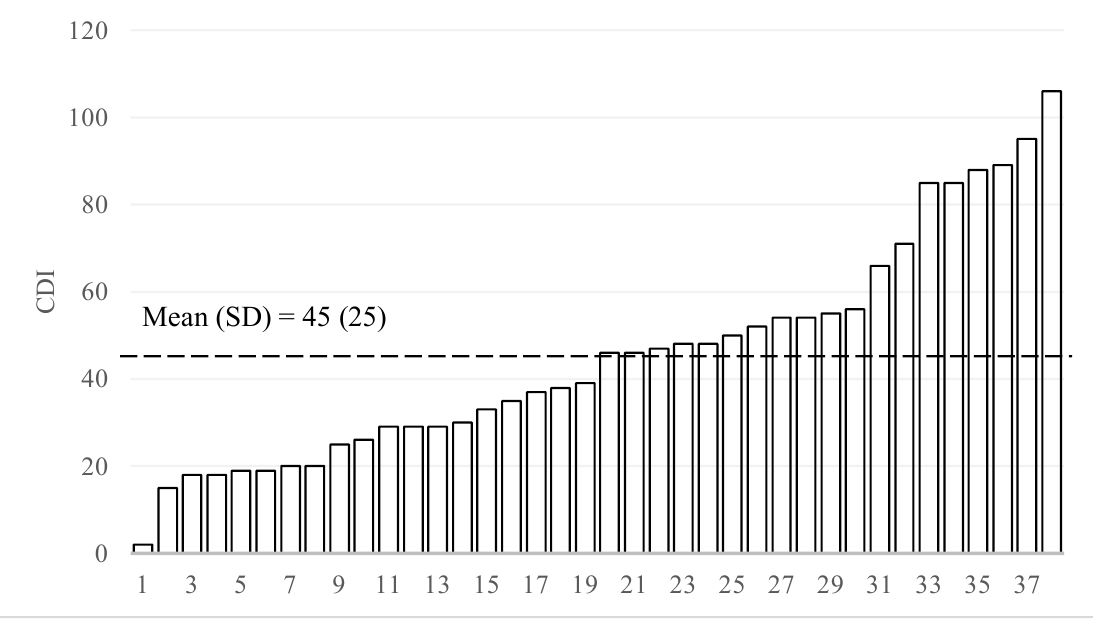
Figure 5. Distribution of MacArthur – Bates Communicative Development Inventories scores (CDI, N = 38). “SD” is defined as standard deviation.